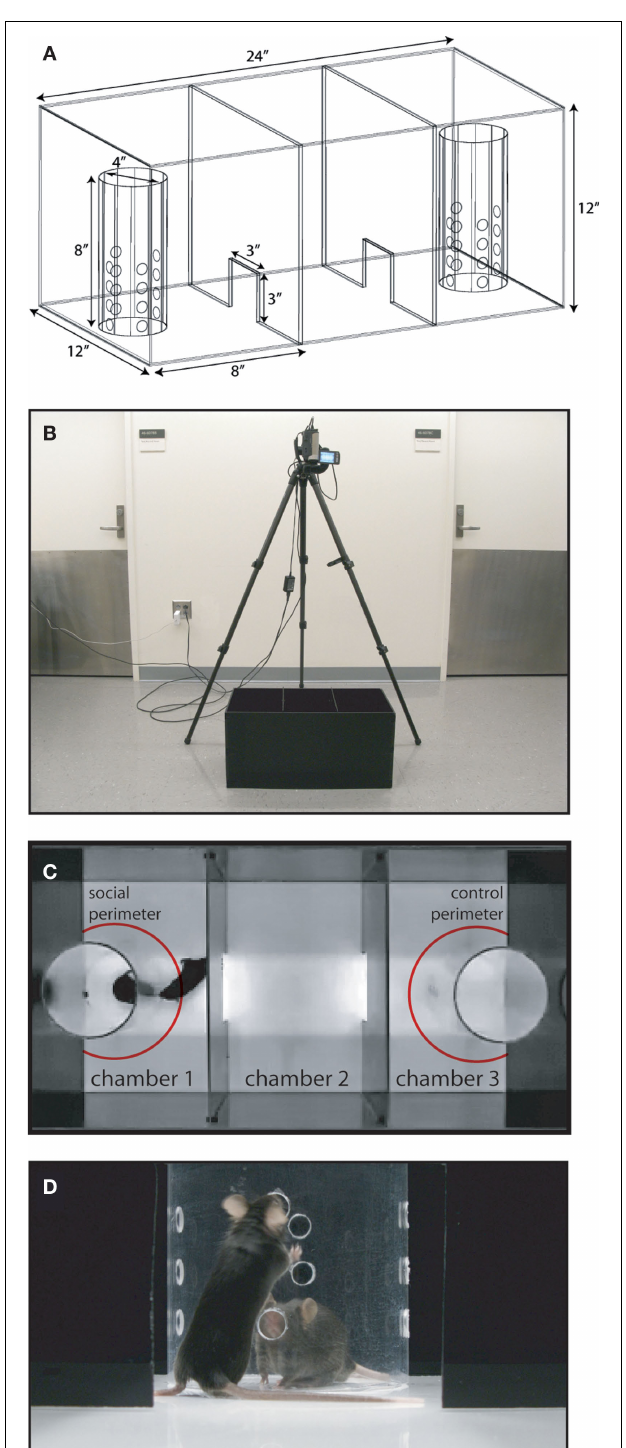
FIGURE 1 | Social approach apparatus setup. (A) Schema of social approach apparatus, showing dimensions. (B) Placement of video camera for recording social approach behavior. (C) Top down view of social approach box, with stimulus mouse in chamber 1. Subject mouse shown is interacting within the social perimeter, indicated in red. (D) View of subject and stimulus mouse interacting in chamber